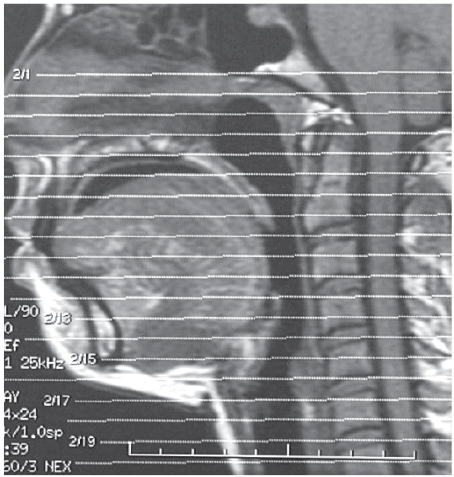
Figure 1 - Axial images programming. The most superior image was programmed cranial to the hard palate, and the most inferior axial image was programmed at the glottic